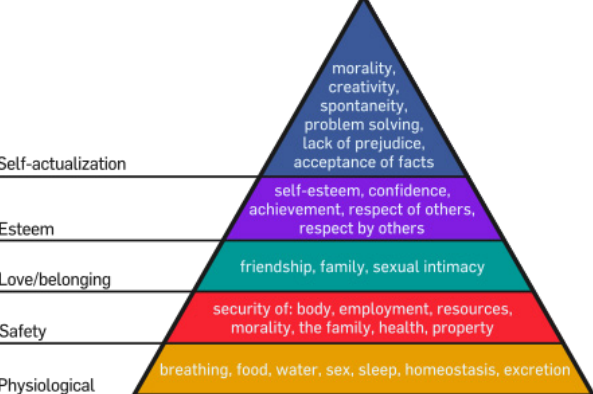
Figure 1: An interpretation of Maslow‘s (1943) hierarchy of needs, represented as a pyramid with the more basic needs at the bottom (from Maslow‘s